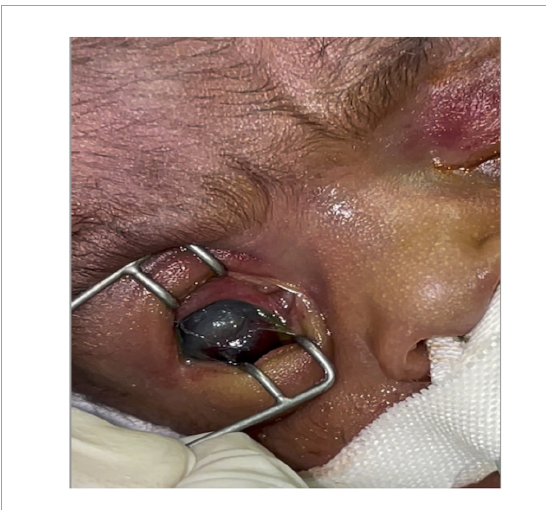
FIGURE2 The right eye perforated corneal ulcer with uveal prolapse.